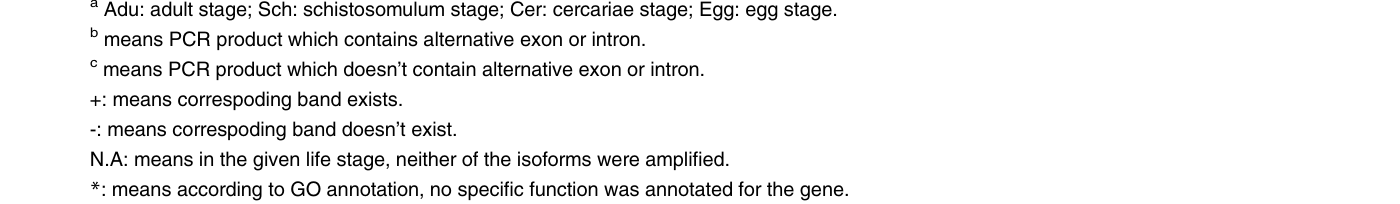
Table 4. Summary of identified alternative spliced genes (II). Gene ID